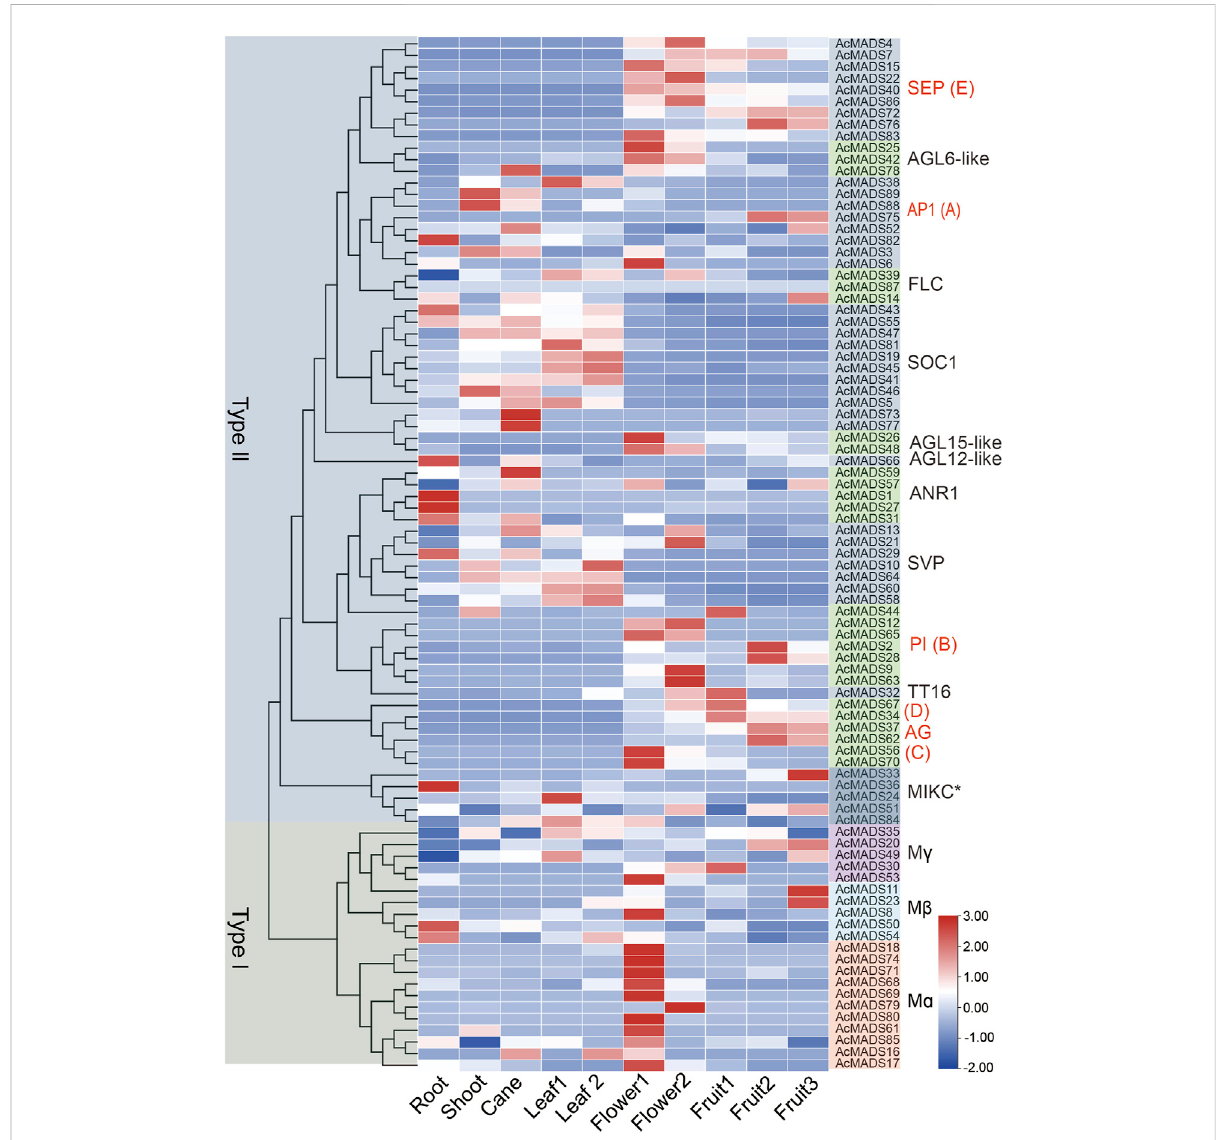
FIGURE 7 Expression pro fi les ofAcMADS-box genes intendifferenttissues ofkiwifruit. Leaf 1,source leaf; Leaf2, sink leaf; Flower 1, fl ower bud; Flower 2, opening fl ower; Fruit 1/2/3,fruitof 20, 147, and 224 days after anthesis. The phylogenetic tree and the subgroup of AcMADS-box genes were on the left and right sides, respectively. The expression levels of AcMADS-box genes from high to low are represented by a heat-map from red to green. Details on expression levels are presented in Supplementary Table